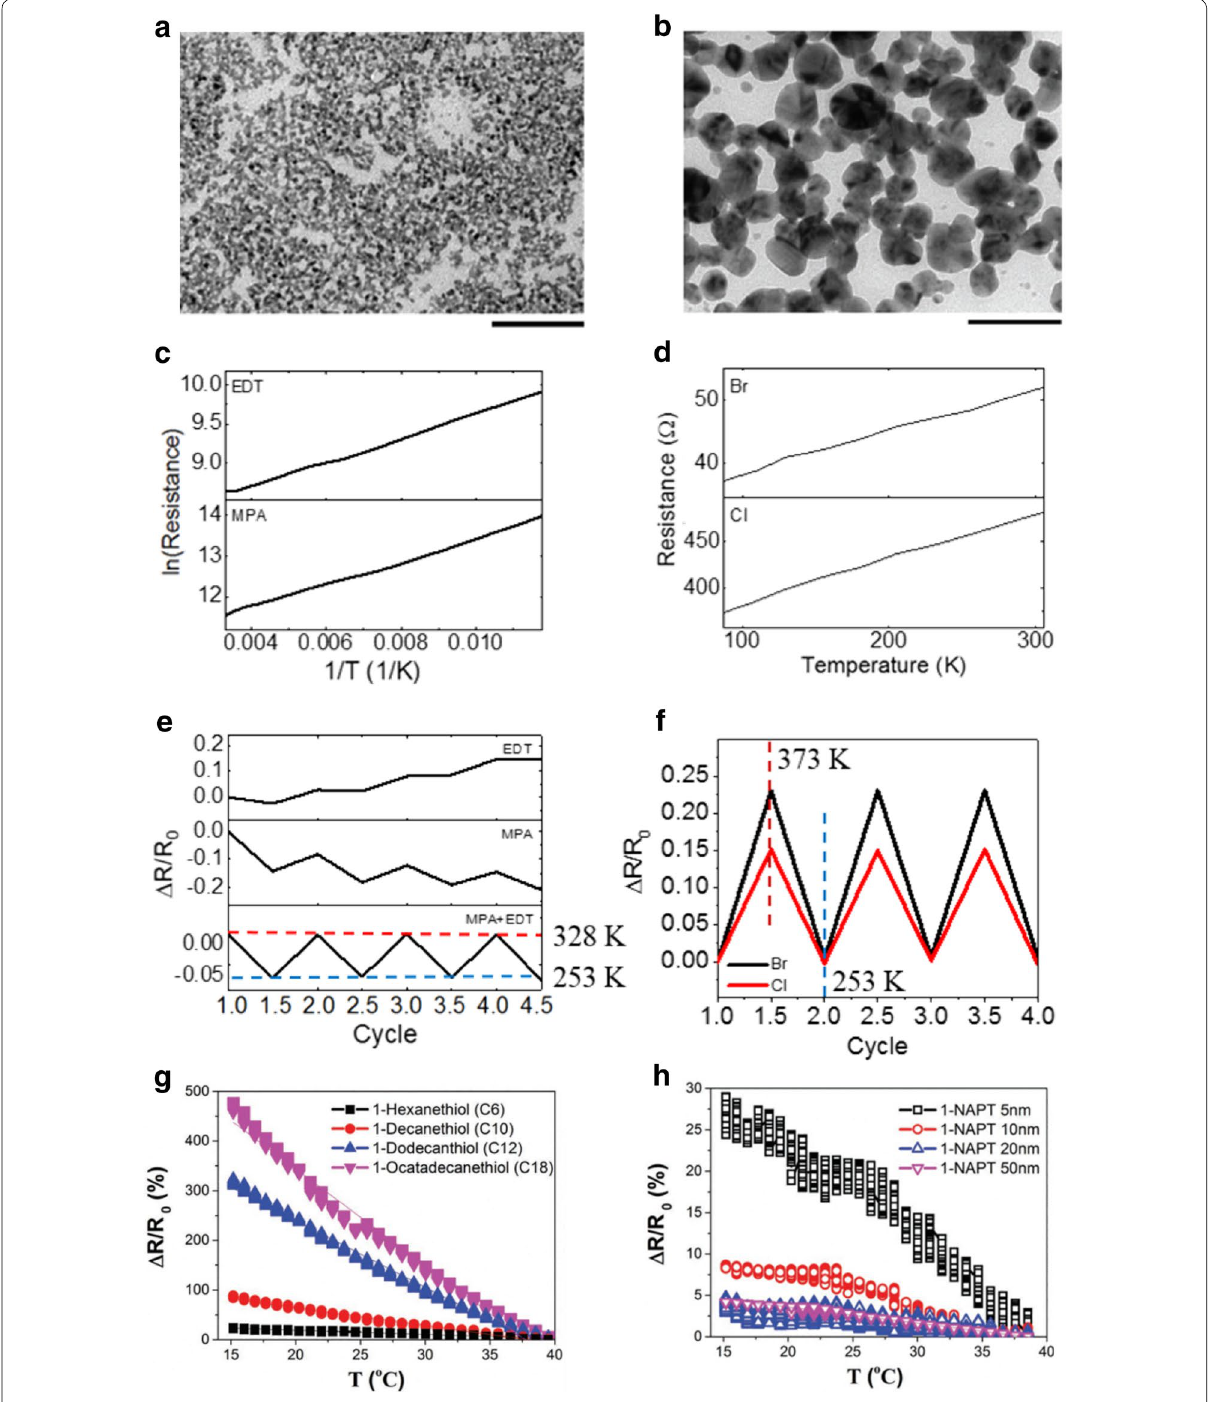
Fig. 6 TEM images of a EDT- and b TBAB-treated Ag NC thin films (scale bar: 100 nm). c Arrhenius plot of resistance and temperature of (top) EDT- and (bottom) MPA-treated Ag NC thin films. d Change in resistance of (top) TBAB- and (bottom) NH 4 Cl-treated Ag NC thin films with respect to temperature. e Change in resistance of (top) EDT-, (middle) MPA-, and (bottom) MPA EDT-treated Ag NC thin films during temperature cycle + tests. f Change in resistance of (red) TBAB- and (blue) NH 4 Cl-treated Ag NC thin films during temperature cycle tests. Temperature-dependent electrical behavior of Au NC thin films with respect to the g type of surface ligands and h NC size (Figure reproduced from a – f [49], Copyright 2017, Wiley-VCH; g , h [76], Copyright 2017,